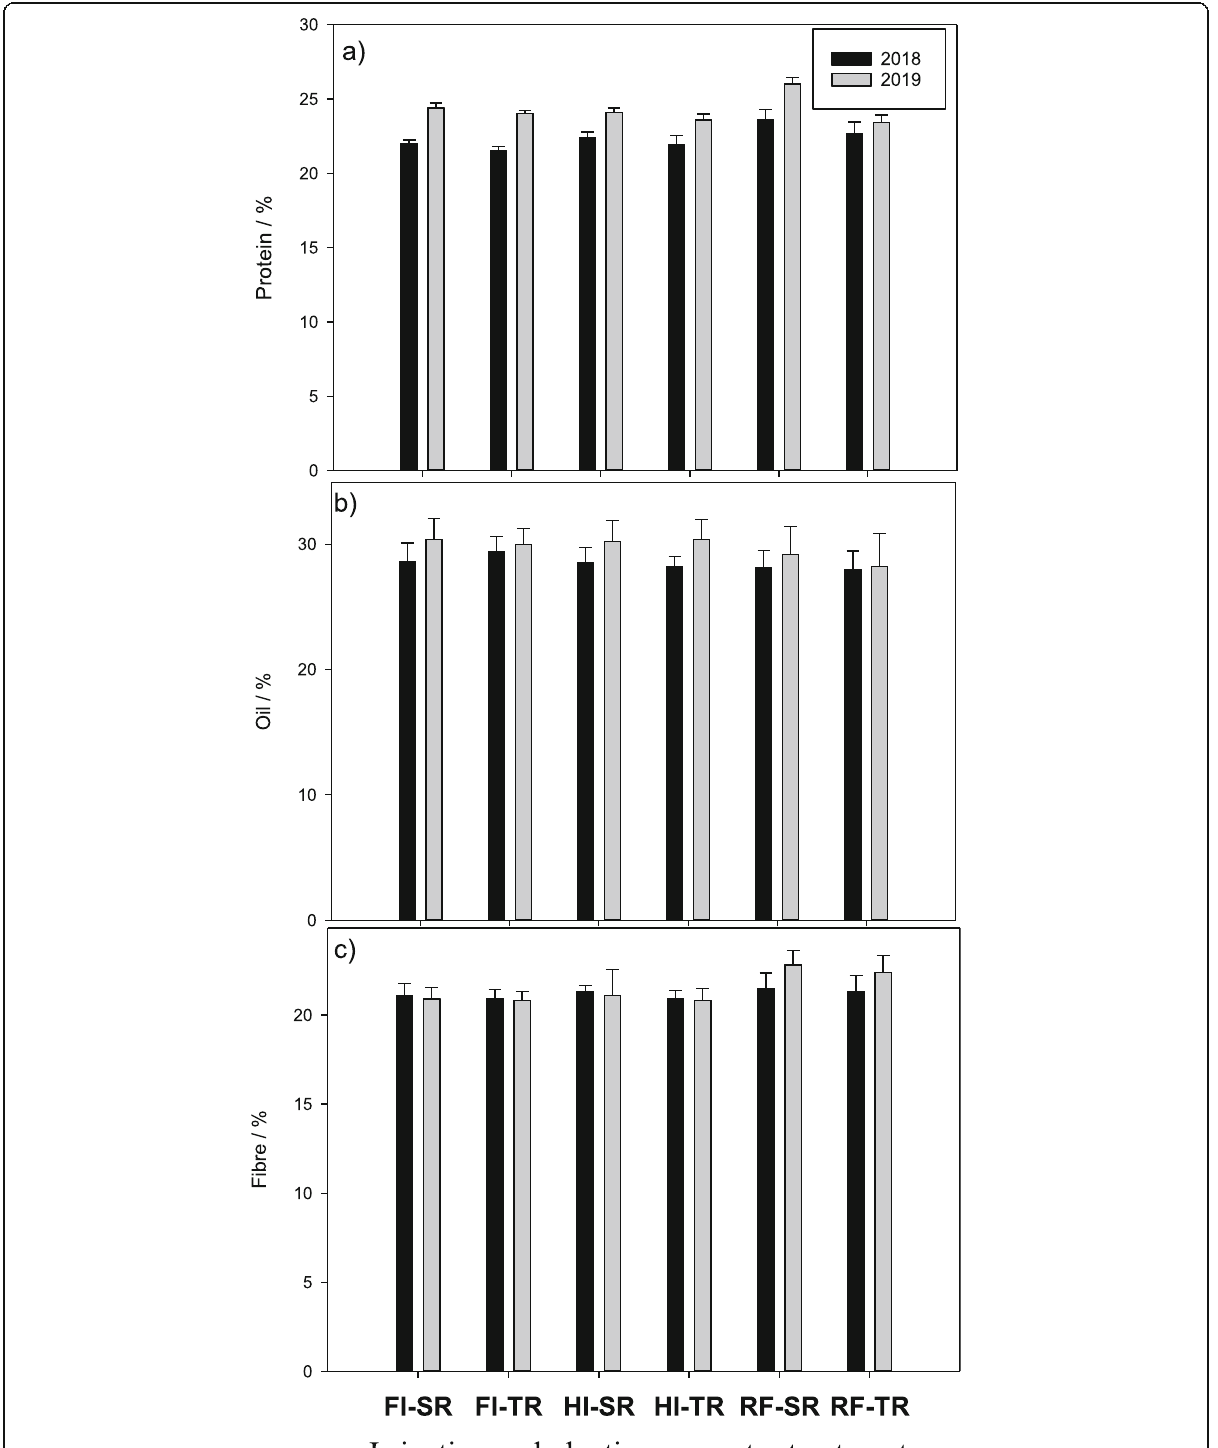
Fig. 2 Effect of irrigation and planting geometry on seed composition traits in 2018 and 2019 seasons a ) protein b ) oil c ) fiber. FI: full irrigation, HI: half irrigation, RF: rain-fed; SR: Single-row and TR: